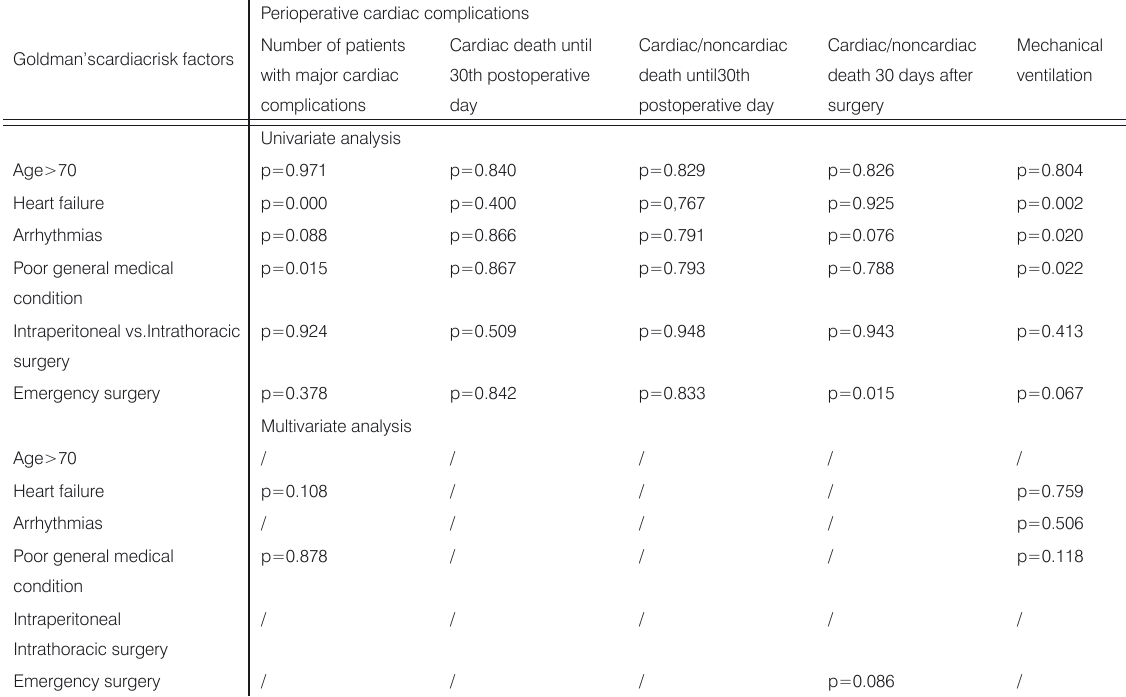
Table 5. Results of logistic regression